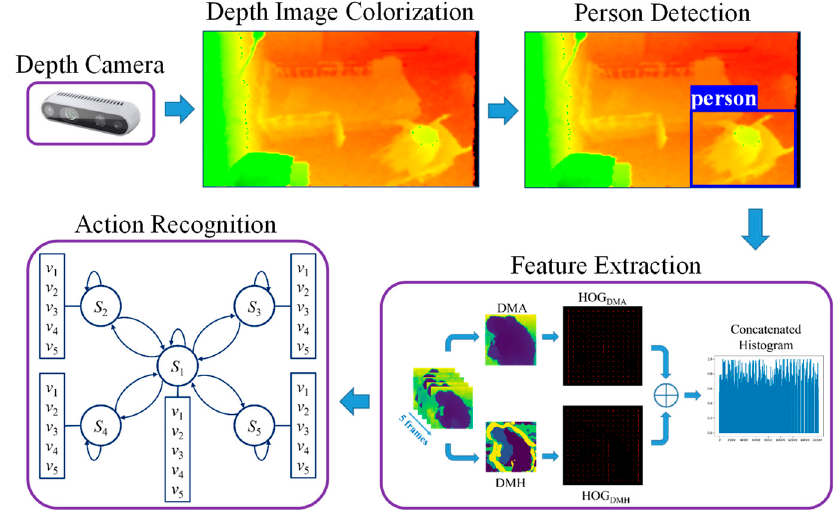
Figure 1. Overview of the proposed system.